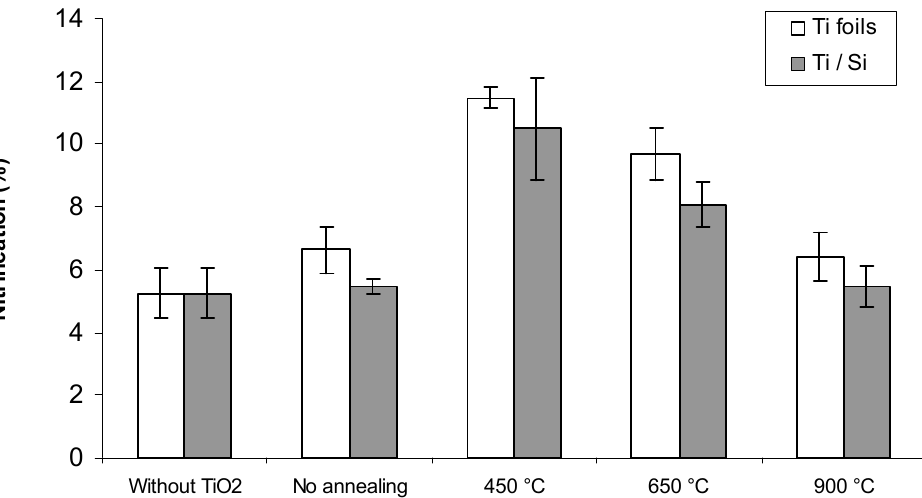
Figure 4. Nitrification of PNA using TiO 2 nanotubes prepared using two substrates: Ti deposed on Si and Ti foils, annealed at various temperatures.